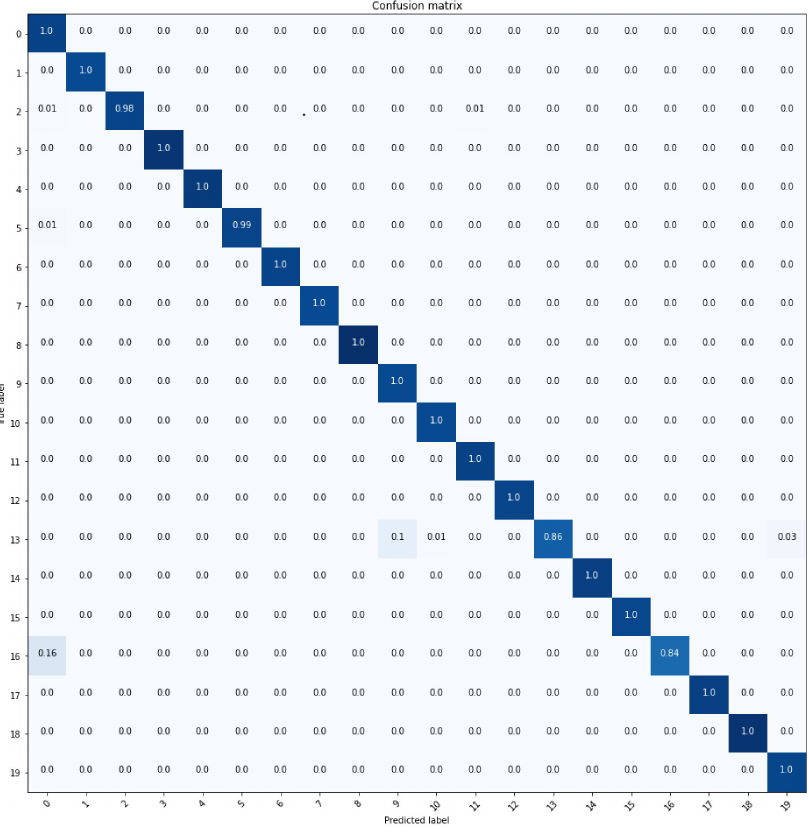
Figure 5. Confusion matrix of the proposed dataset.